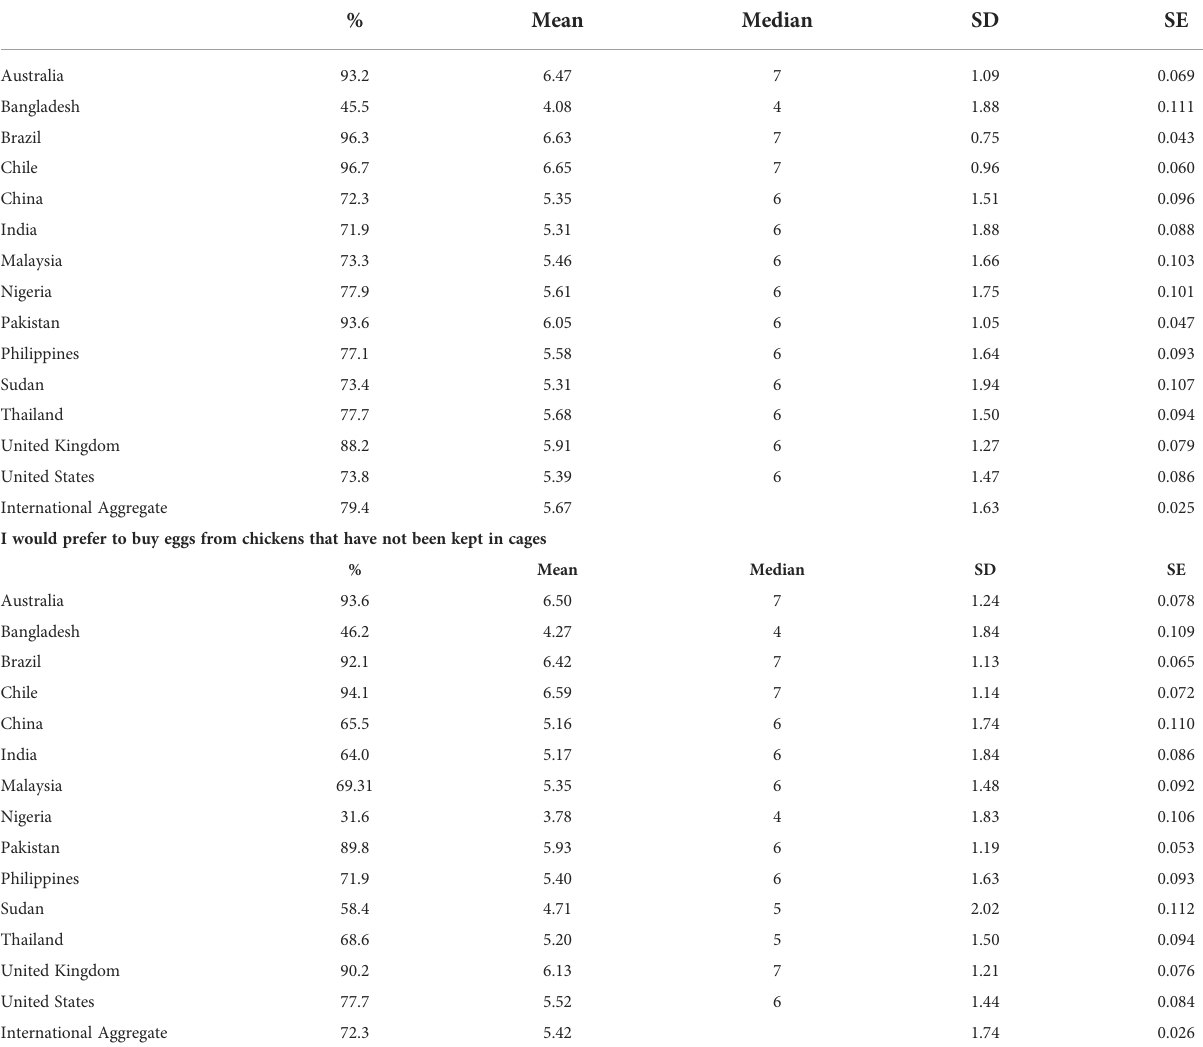
TABLE 4 Means for the level of agreement with animal welfare focused statements regarding egg production by country, utilising 7-point Likert scale, and percentage of general agreement with